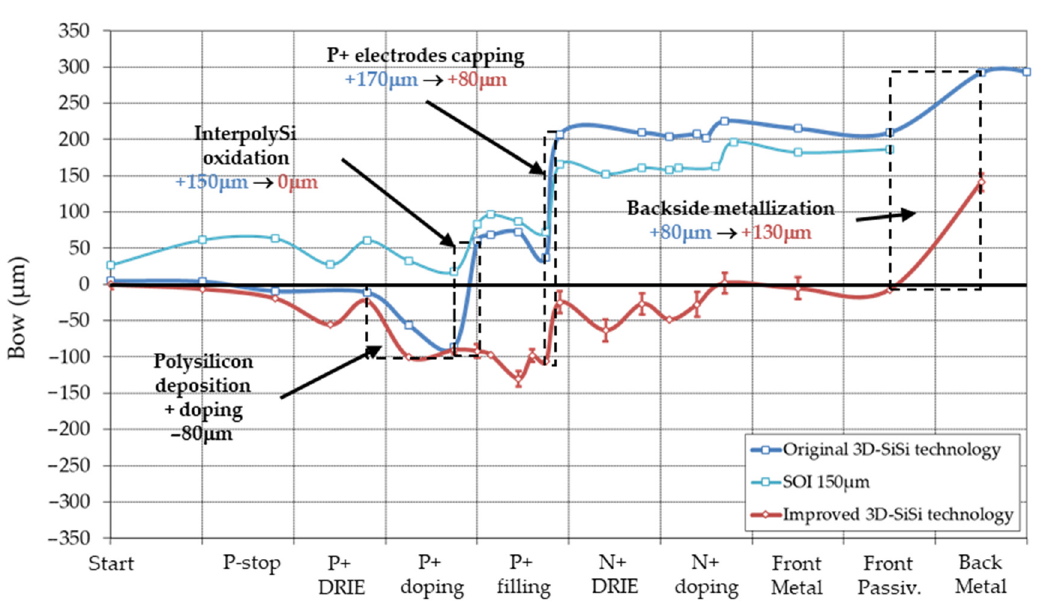
Figure 18. Bow variation during process of Si-Si wafers with 150 µ m active silicon (350 µ m total thickness) for original (blue) and improved technologies (red). Bow variation for a 150 / 1 / 300 µ m SOI wafer is shown for comparison (light blue). Main stress contributors for SiSi wafer are indicated on the graph.